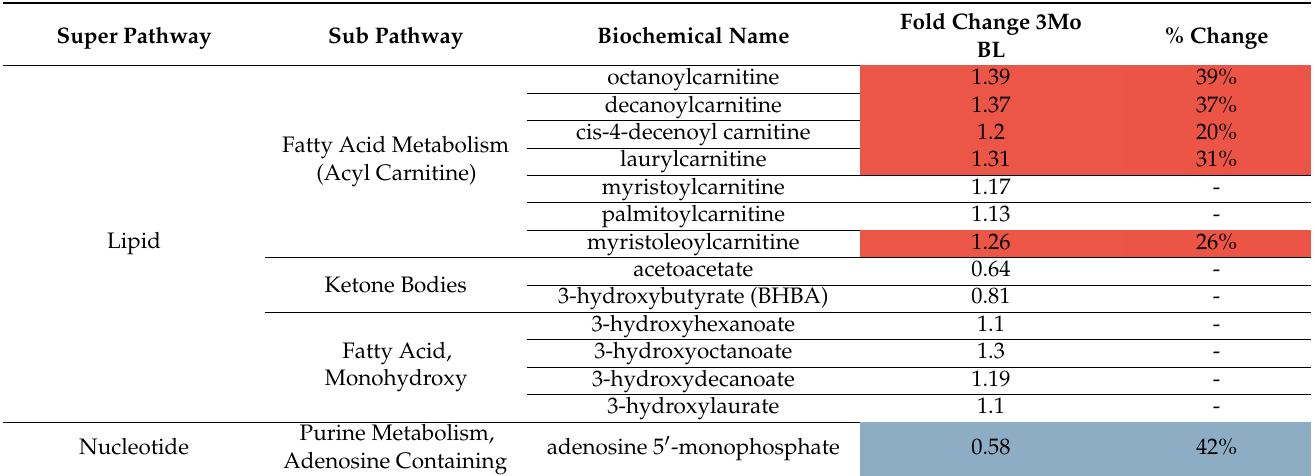
adenosine 5 (cid:48) -monophosphate Adenosine Containing Significant metabolite increases and decreases are highlighted in red and blue, respectively.